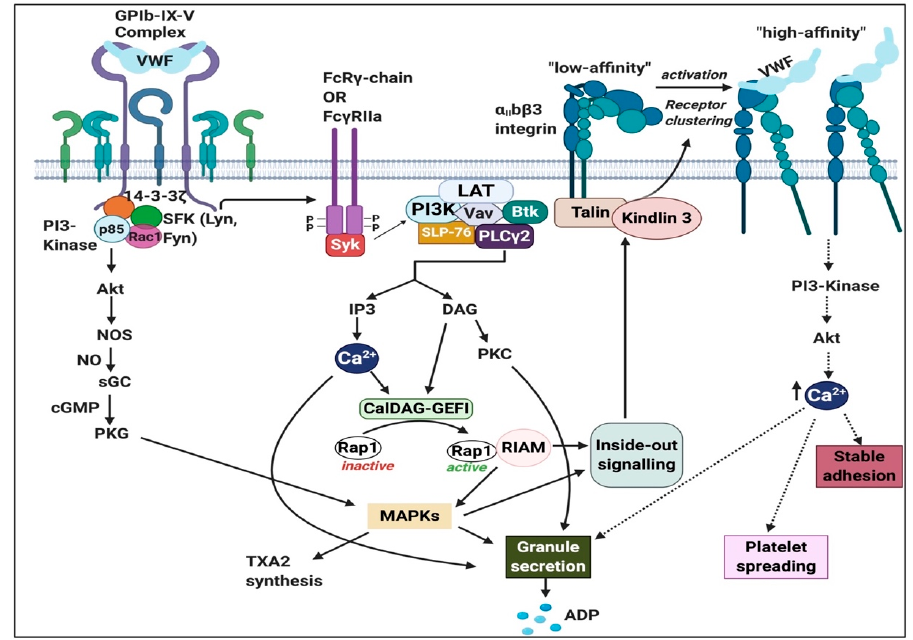
Figure 7. The signalling pathway of von Willebrand factor (VWF) in platelets via the GPIb-IX-V complex (with GPIb α ) leading to integrin α II b β 3 activation and the important role of the FcR γ -chain and Fc γ RIIa immunoreceptor tyrosine-based activation motif (ITAM) pathway: Adapted from [112, 118]. Abbreviations: ADP, adenosine triphosphate; Btk, Bruton tyrosine kinase; CalDAG-GEFI, Ca 2 + -dependent guanine nucleotide exchange factor; DAG, diacylglycerol; IP3, inositol